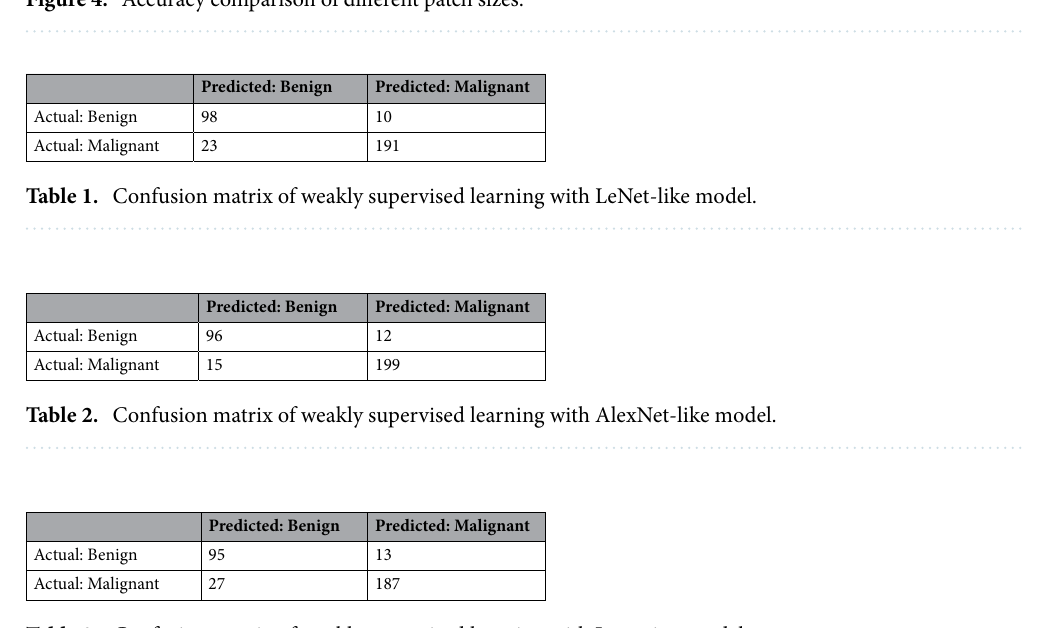
Table 3. Confusion matrix of weakly supervised learning with Inception